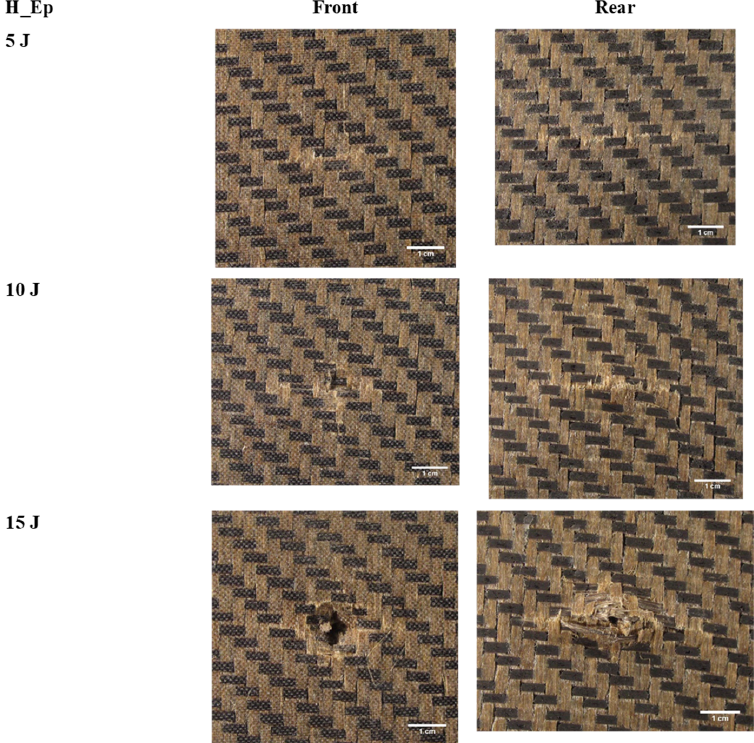
Figure 11. Close-up view of impact damage progression on front and rear surfaces of epoxy-based impacted specimens.